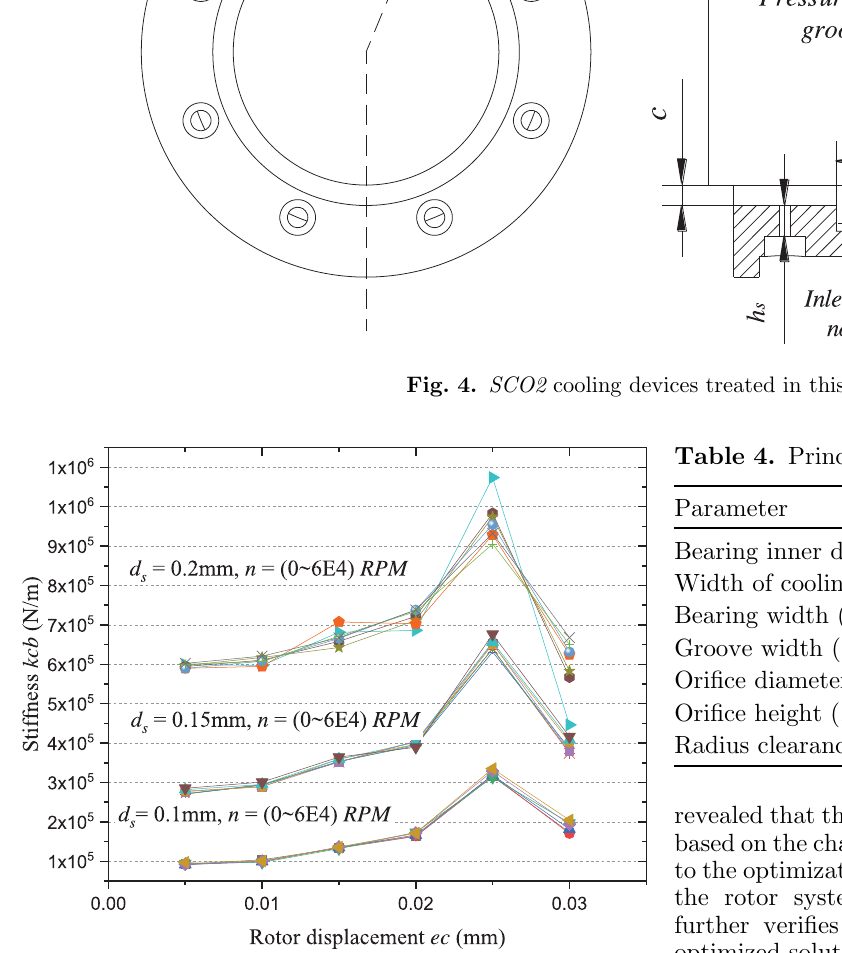
Fig. 5. Dynamic stiffness coef fi cient versus rotor displacement with different diameters d s .